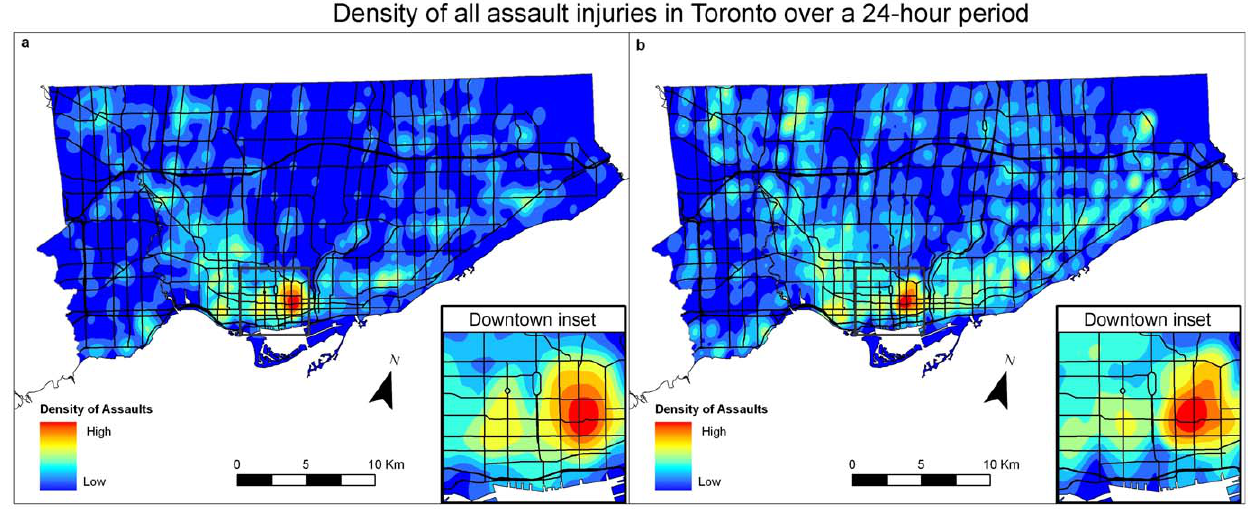
Figure 2. Assault injury densities in Toronto using data aggregated for 24 hours. Figure 2a: Density of all assault injuries for EMS dataset over a 24-hour period. Figure 2b: Density of all assault injuries for NACRS dataset over a 24-hour period.